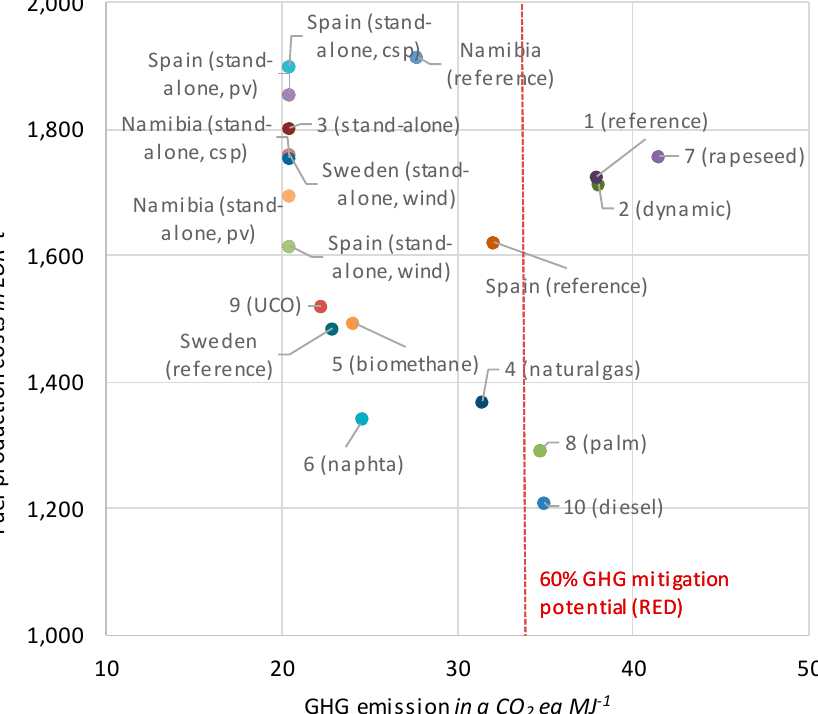
Figure 5. Comparison of production costs and GHG emissions for di ff erent scenarios and exemplary favorable regions.